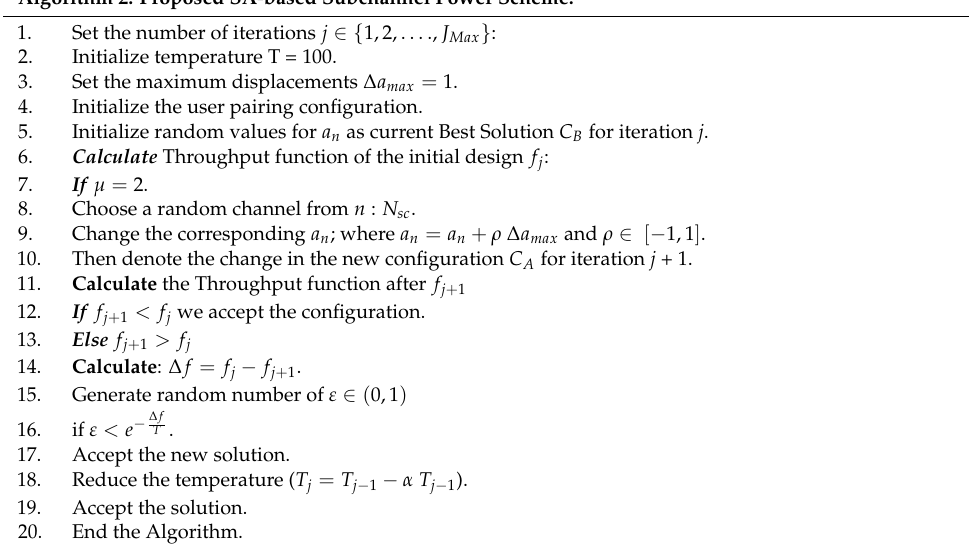
Algorithm 2: Proposed SA-based Subchannel Power